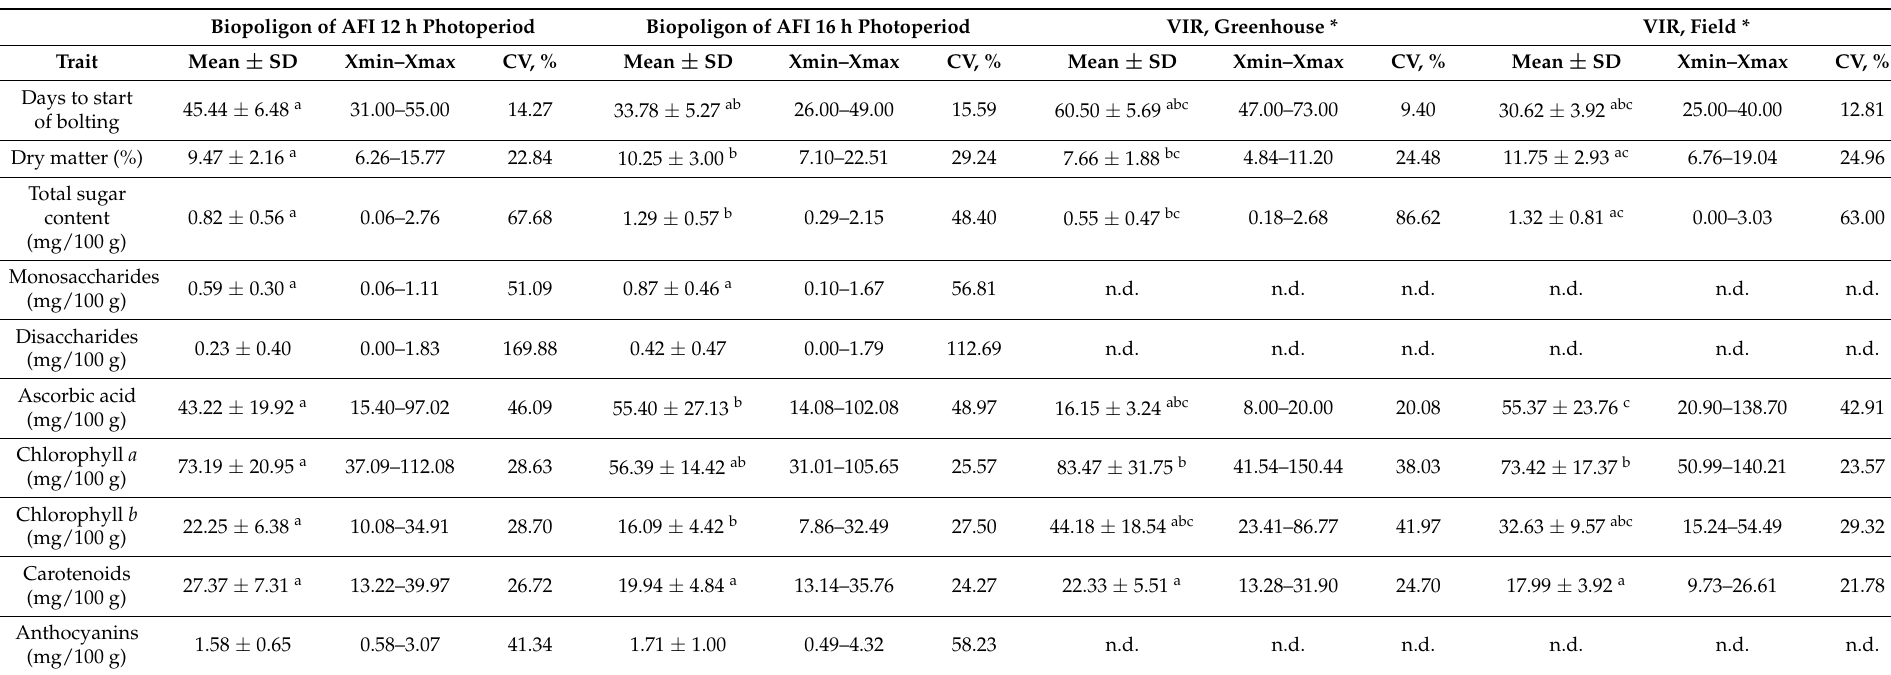
Table 2. The timing of the start of bolting and the content of nutrients and biologically active substances in the lines of the mapping population DH 38. Biopoligon of AFI 12 h